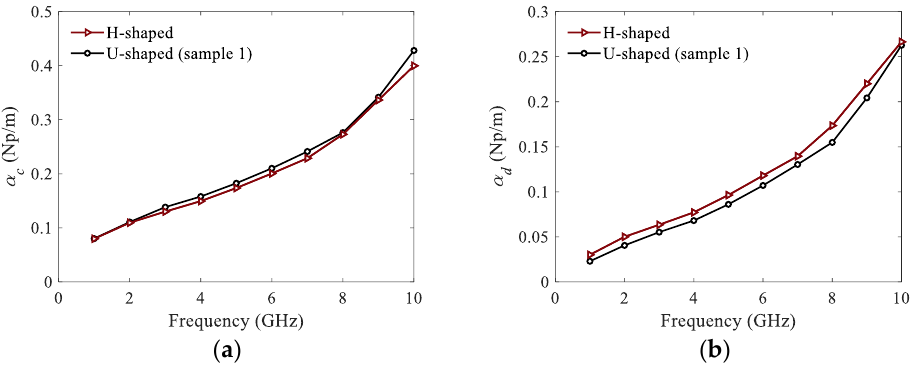
Figure 11. Attenuation constants of the corrugated SWTLs: ( a ) conductor attenuation; ( b ) dielectric attenuation.